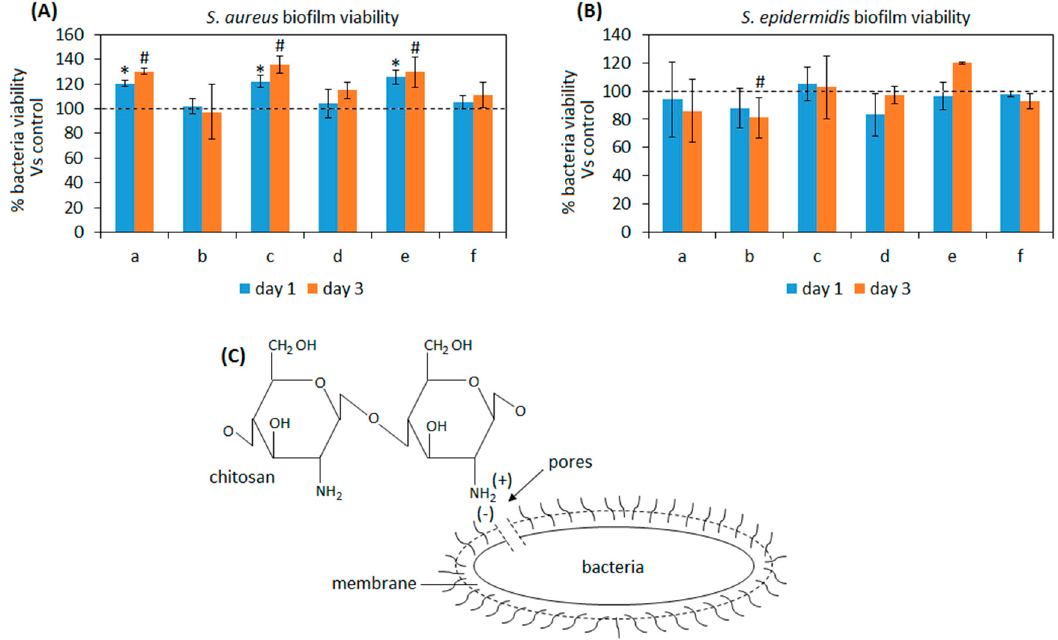
Figure 5. Composites’ antibacterial properties towards Staphylococcus aureus ( A , SA) and Staphylococcus epidermidis ( B , SE). Only the composite b (BG-chitosan-GPTMS wt20%) was successful in counteracting SA biofilm and significantly reducing SE after 3 days in comparison with bulk 100% BG in water paste controls ( p < 0.05, indicated by #) due to chitosan properties as schematized in ( C ). On the opposite, samples a-c-e reported a higher contamination in comparison to the control ( p < 0.05, indicated by the *) with SA infection. Bars represent means and standard deviations. a: BG-Cn-GPTMS10, b: BG-Cn-GPTMS20, c: BG-Gel-GPTMS10, d: BG-Gel-GPTMS20, e: BG-Cn-Gel-GPTMS10, f: BG-Cn-Gel-GPTMS20. Experiments were performed using six replicates for each specimen.